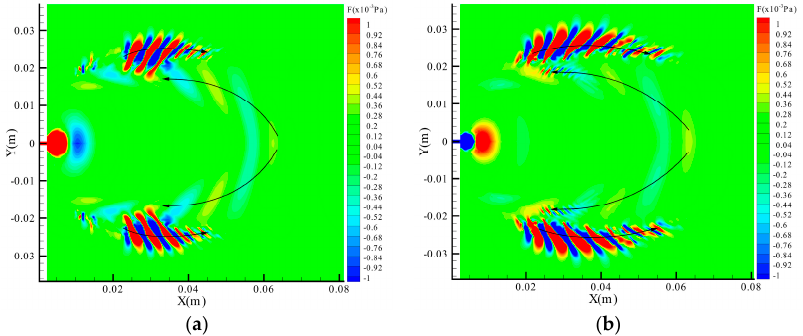
Figure 14. Pressure fluctuation contour of different external temperature (The arrow marked in the figure represents the direction of fluctuation wave propagation.). ( a ) 393 K; ( b ) 173 K.